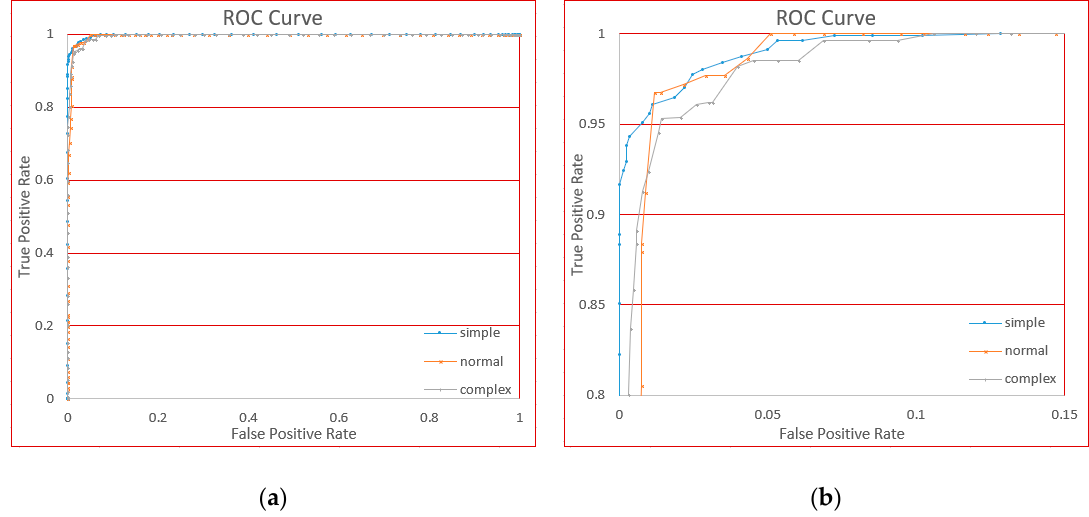
Figure 18. The receiver operating characteristic (ROC) curves for three gestures. ( a ) Is the global view and ( b ) is the local view for clarity.